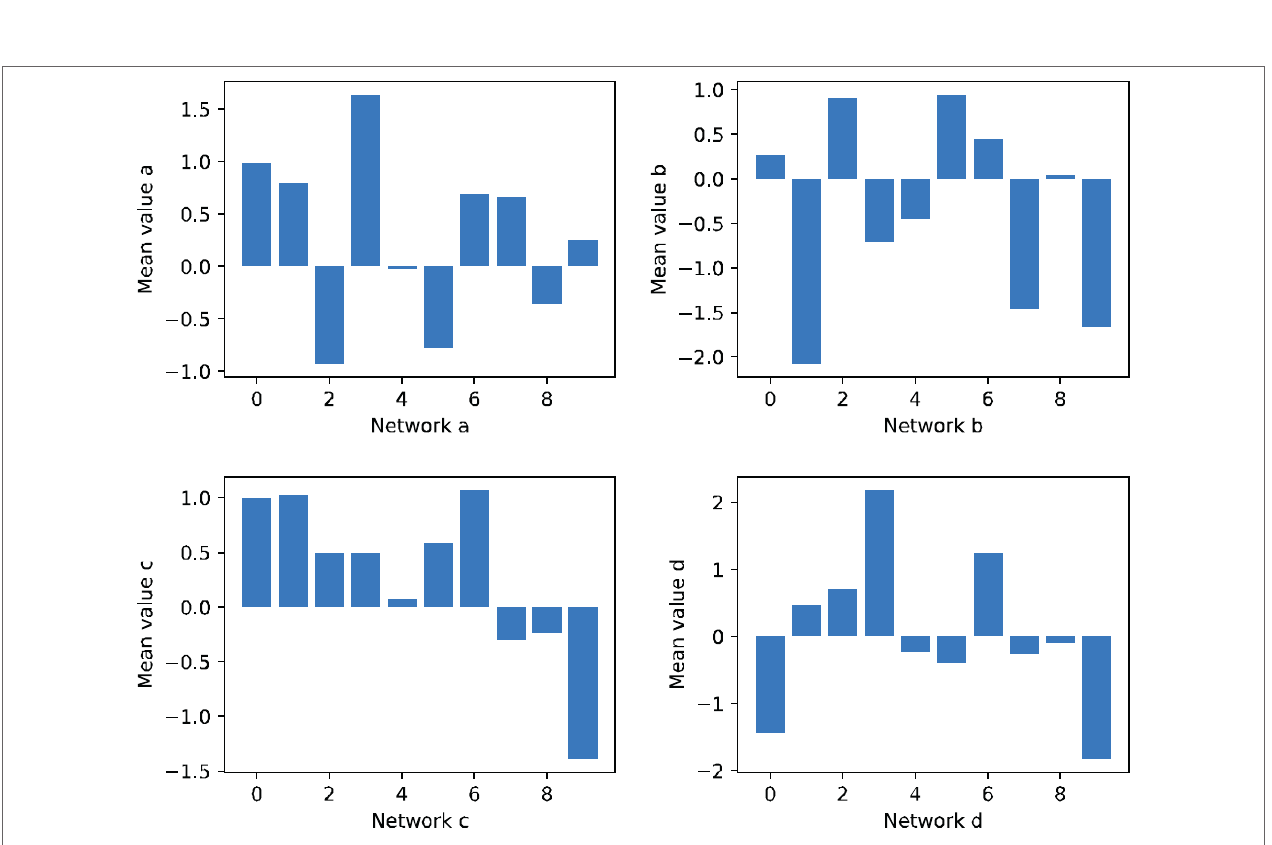
FIGURE 4 | Analysis of the maximization of the correlation of teachers’ teaching psychological